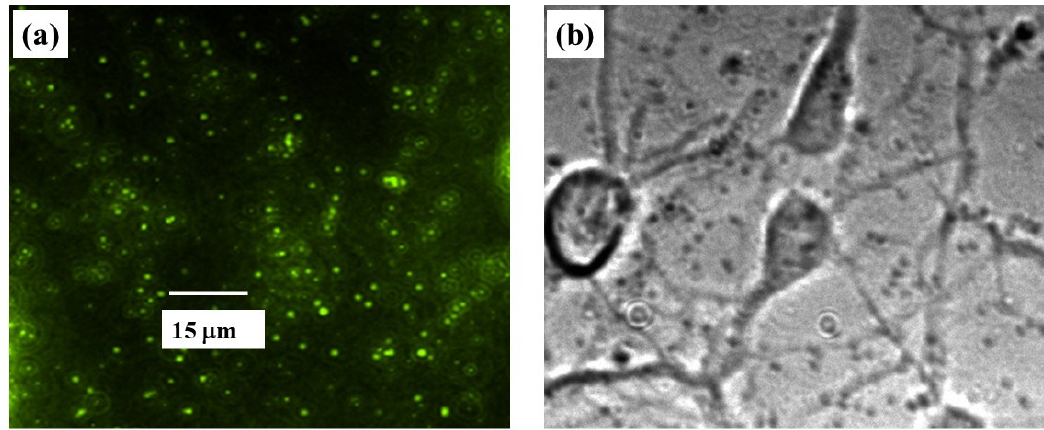
Figure 6. ( a ) Example of reference fluorescent image of the PAA substrate with embedded FluoSphere beads; ( b ) optical bright-field image of cortical neurons cultured on the substrate shown in ( a ). The scale bar shown in ( a ) is the same for both images.